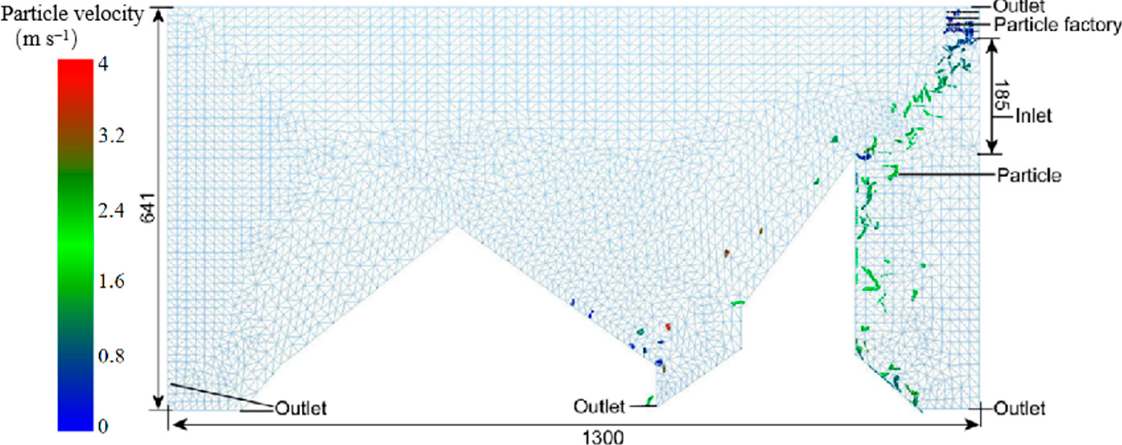
Figure 4. Simulation flow field (units: mm).